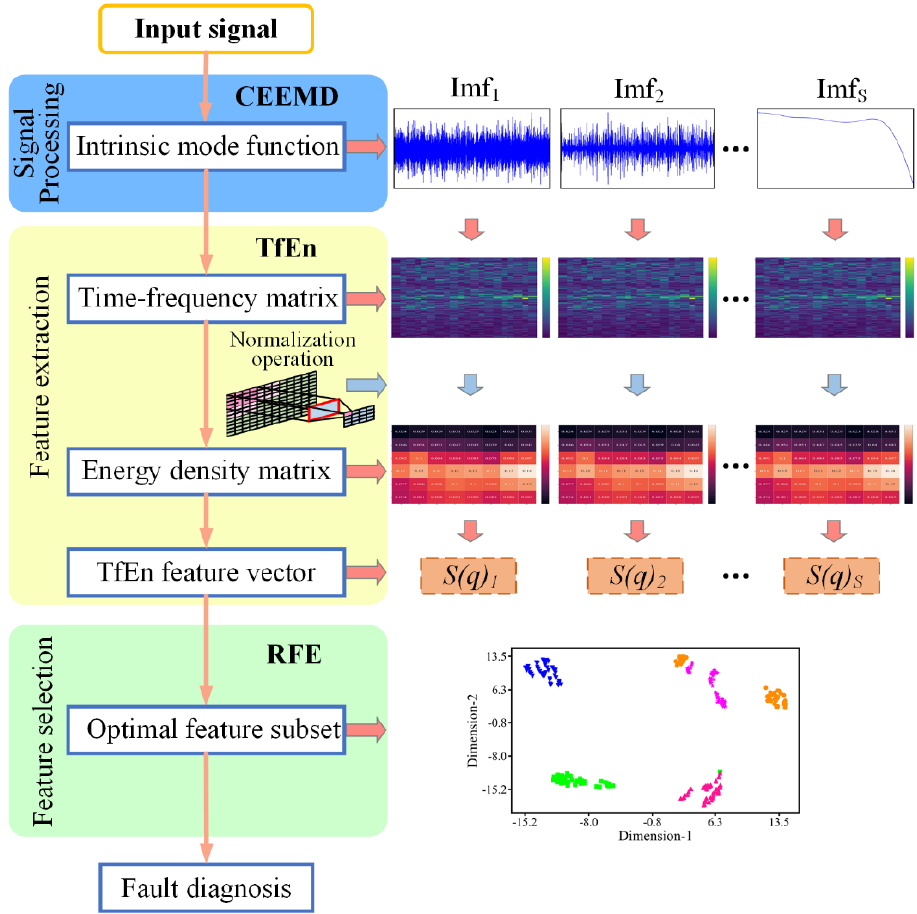
Figure 1. The procedure of the proposed fault diagnosis method.